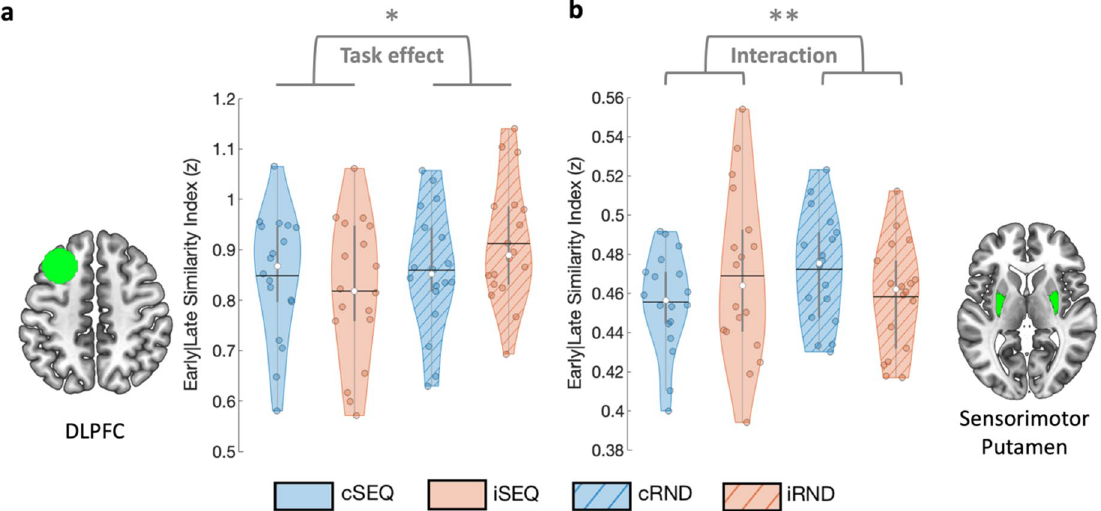
Figure 4. Similarity between early and late task practice stages. ( a ) DLPFC pattern similarity between early and late task practice was influenced by task condition such that sequence learning resulted in lower early-late similarity as compared to random practice. ( b ) The sensorimotor part of the putamen showed a significant task by stimulation interaction whereby early-late similarity was lower during sequence as compared to random practice, after cTBS as compared to iTBS. Colored circles represent individual data, jittered in arbitrary distances on the x-axis within the respective violin plot to increase perceptibility. Black horizontal lines represent means and white circles represent medians. The shape of the violin plots depicts the distribution of the data and grey vertical lines represent quartiles. Asterisk indicates significance at p < 0.05 (*) and at p FDR < 0.05 (**). Violin plots were created with 62 . DLPFC - dorsolateral prefrontal cortex, SEQ - sequence learning task version, RND - random task version, c - continuous, i -